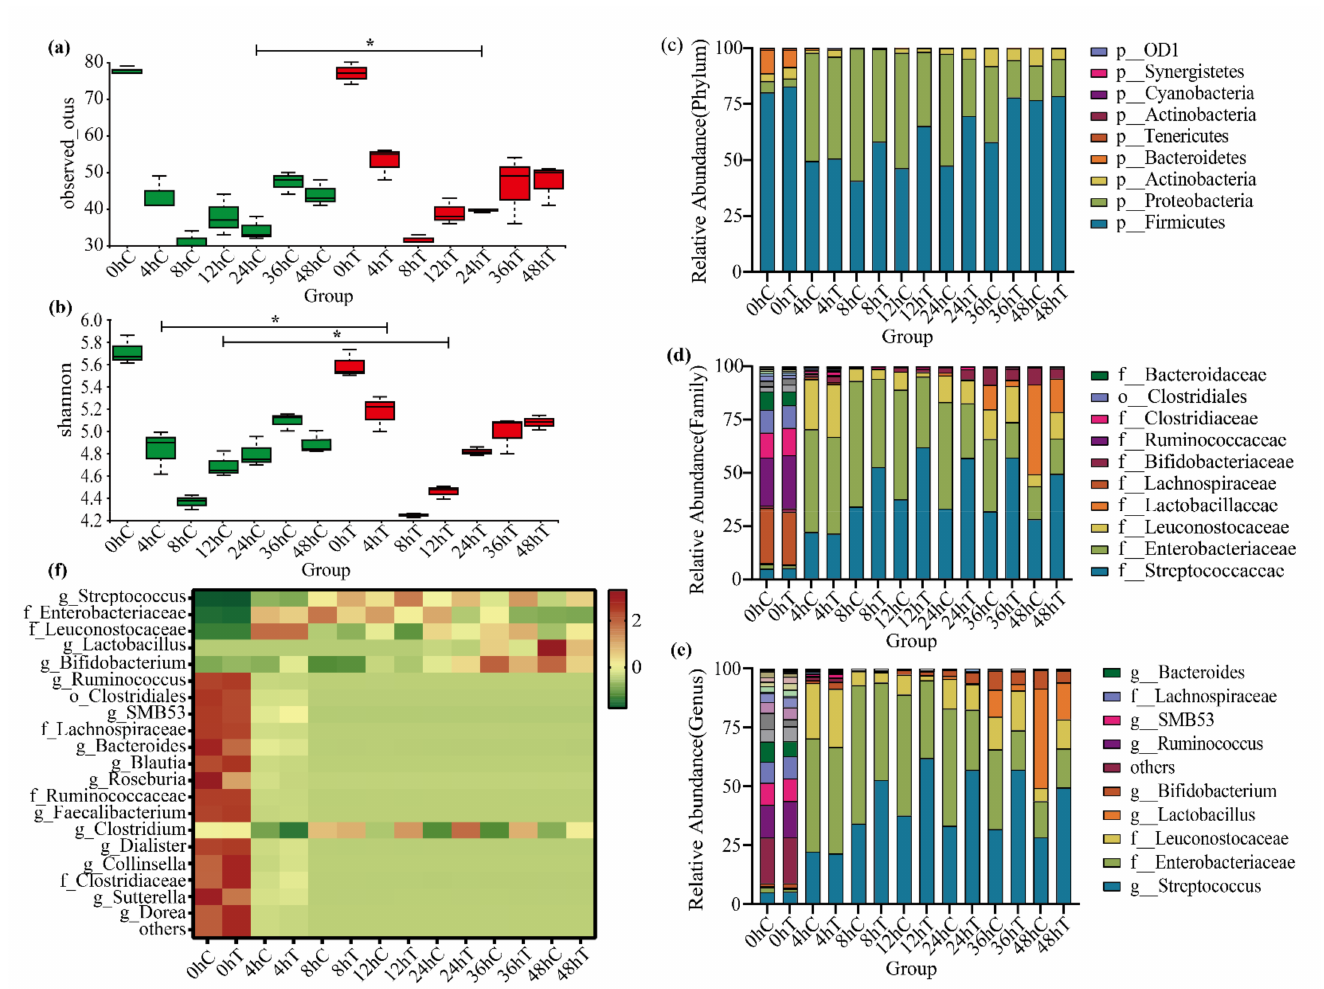
Figure 4. The 020402_LYZ M1 protein modulates the composition of gut microbiota. The numbers of replicated samples in this figure are as follows: 0 h ( n = 3), 4 h ( n = 3), 8 h ( n = 3), 12 h ( n = 3), 24 h ( n = 3), 36 h ( n = 3), 48 h ( n = 3); C: control group; T: treatment group. ( a ) Observed Otus. ( b ) Shannon index. ( c ) Top eight of the relative abundances of gut microbiota at Phylum level. ( d ) Top ten at Family level. ( e ) Top ten at Genus level. ( f ) Heatmap at Genus level. * p < 0.05, T